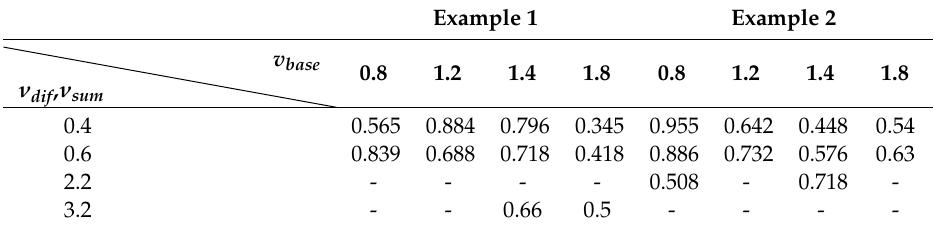
Table 2. Correlation coe ffi cients c ν between the basis frequency ν = v base and the di ff erence ν base , dif frequency ν = ν dif or the sum frequency ν = ν sum . Empty squares mean that the corresponding values of the correlation coe ffi cient were not computed. Example 1 Example 2 ν ν dif ,